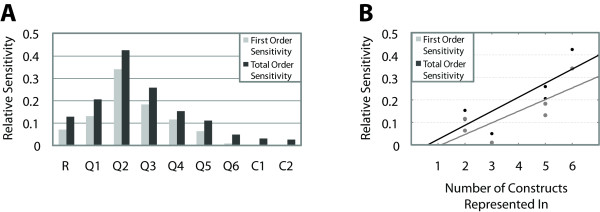
Sensitivity analysis using the eFAST global sensitivity method on the thermodynamic model of Fakhouri et al., scheme 2. A) Shown are first- and total-order sensitivity indices, which represent the amount of variation in the model output with respect to each parameter individually (gray bars) and in conjunction with all other parameters (black bars), scaled from 0.0 to 1.0. If the gray bar is much smaller than the black bar, as in Q6, secondary (or higher) effects are predominant. Quenching parameters are generally most sensitive and cooperativity parameters are least sensitive. B) Effect of frequency with which a quenching parameter is represented in the twelve constructs on sensitivity. The number of constructs that the parameter is represented in is shown along the horizontal axis. Corresponding first- and total-order sensitivity indices are shown for each quenching parameter, as calculated by the eFAST algorithm. There are two quenching parameters (Q4 and Q5) represented in 2 constructs, and two quenching parameters (Q1 and Q3) represented in 5 constructs. At these values, there are four data points, two for each quenching parameter. The lines illustrate linear fits to each data set, first- and total-order sensitivity indices. In general, the more constructs a quenching parameter is represented in, the more sensitive that parameter.